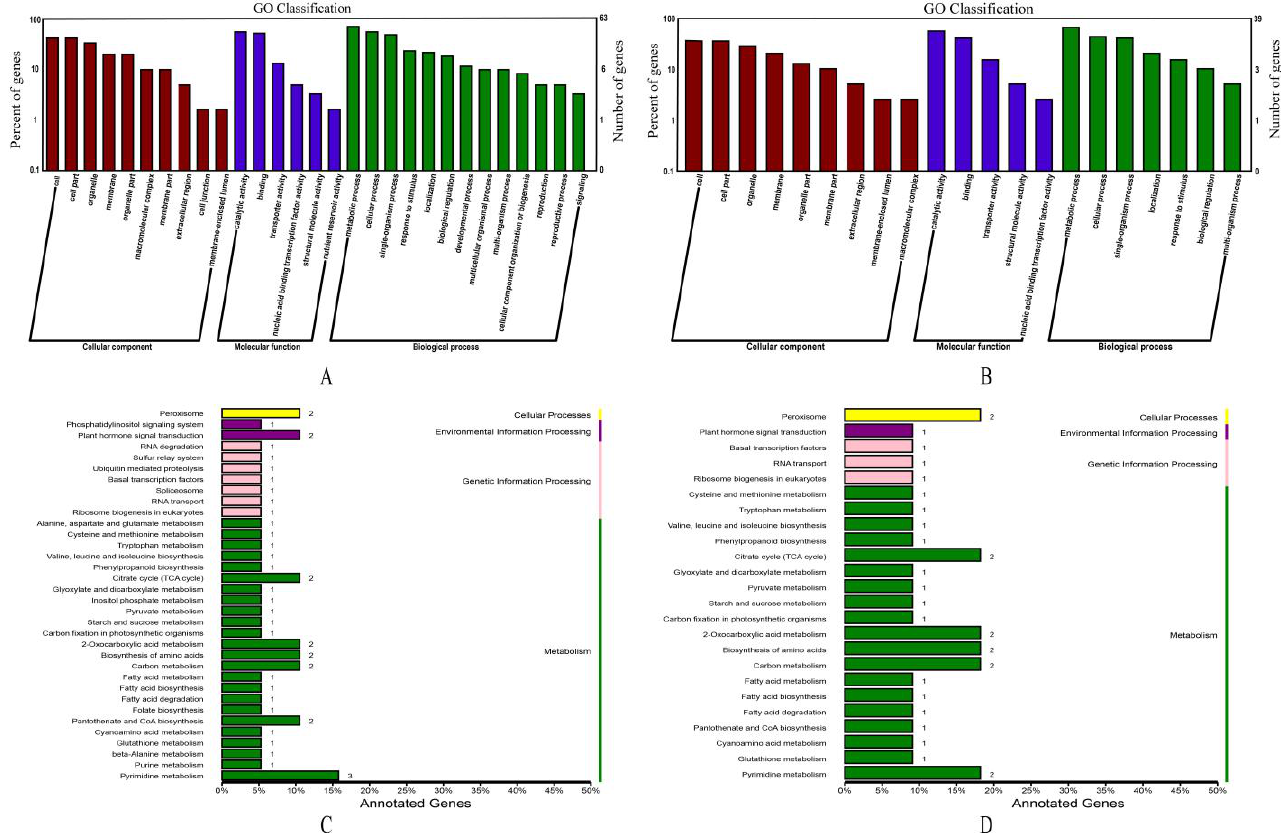
Figure 6. Enrichment analysis of the candidate genes in sugarcane traits of tillering and ratooning associated regions. ( A , C ) represent GO functional annotation and KEGG pathway annotation of candidate gene sequences associated with tillering trait, respectively. ( B , D ) are similar to ( A , C ), but represent sequences associated with ratooning. In the C and D plots, the number after the box bar represents the number of genes annotated in this pathway.